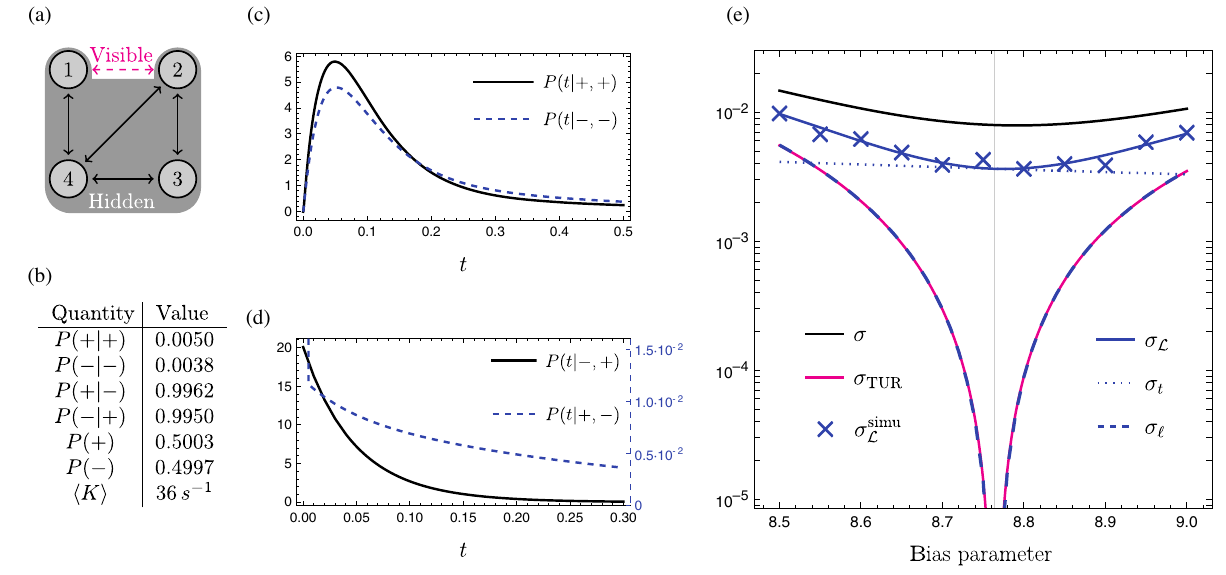
FIG. 6. Estimating the entropy production rate ( k B =s ) from repeated transition statistics. (a) Illustration of the inference scheme for a network with the observation of transitions þ ¼ 1 → 2 and − ¼ 2 → 1 . From the analytical equations derived in Sec. III B, we show (b) conditional and unconditional probabilities of transitions, and the value of the traffic rate, intertransition-time probability densities for (c) repeated and (d) alternated transitions. In terms of a bias parameter, in panel (e), we show entropy production σ as a solid black curve, the thermodynamic uncertainty relation ’ s lower bound σ as a solid magenta curve, and results from Gillespie simulation σ simu L TUR as blue crosses. Next, we show the present results of the inferred entropy production rate σ L in solid blue, its decomposition in intertransition times σ t is given in dotted blue, and the sequence of transitions σ l in dashed blue. The vertical line is the value of the (dimensionless) bias parameter for which the visible current vanishes. The transition rates are W 24 ¼ W 34 ¼ W 41 ¼ W 43 ¼ 1 , W W W W 20 , and W – (e), the bias parameter is fixed to 14 ¼ 21 ¼ 32 ¼ 42 ¼ 12 equals the exponential of the bias parameter. In panels (b) 8.5. Simulations were performed with a Gillespie algorithm for 2 × 10 6 s, and the Kullback-Leibler divergence of intertransition times was obtained with an unbiased estimation scheme (cf. main